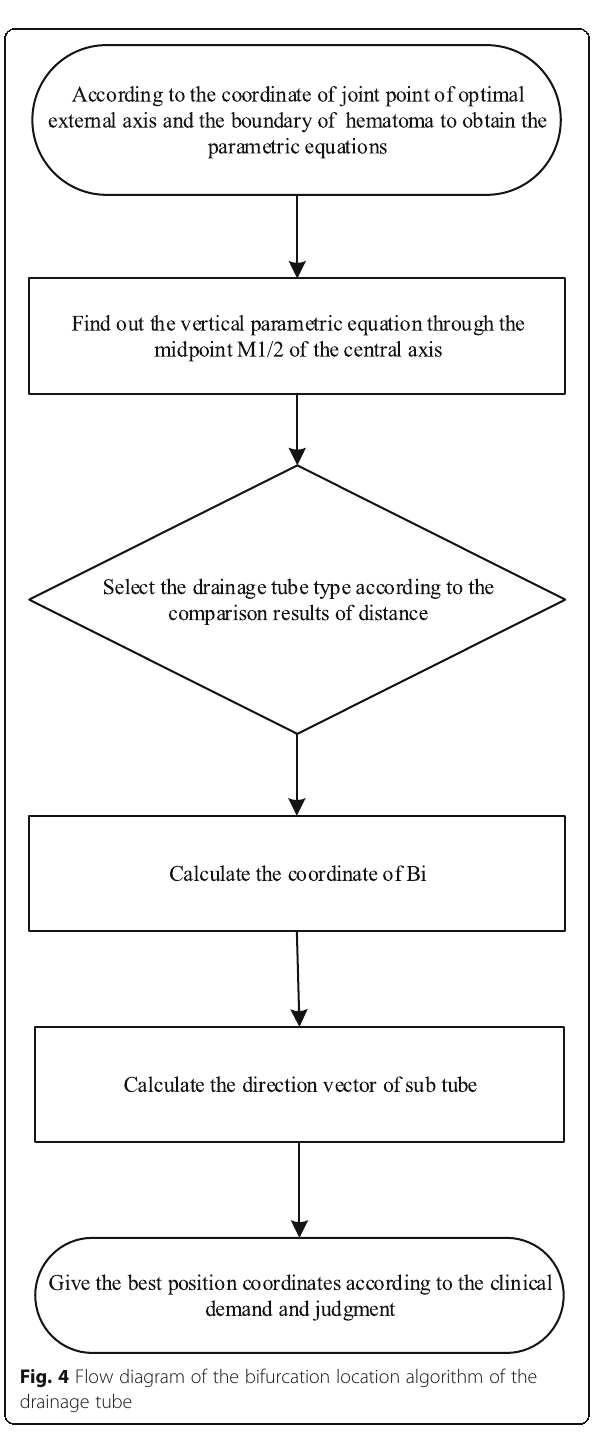
Fig. 4 Flow diagram of the bifurcation location algorithm of the drainage